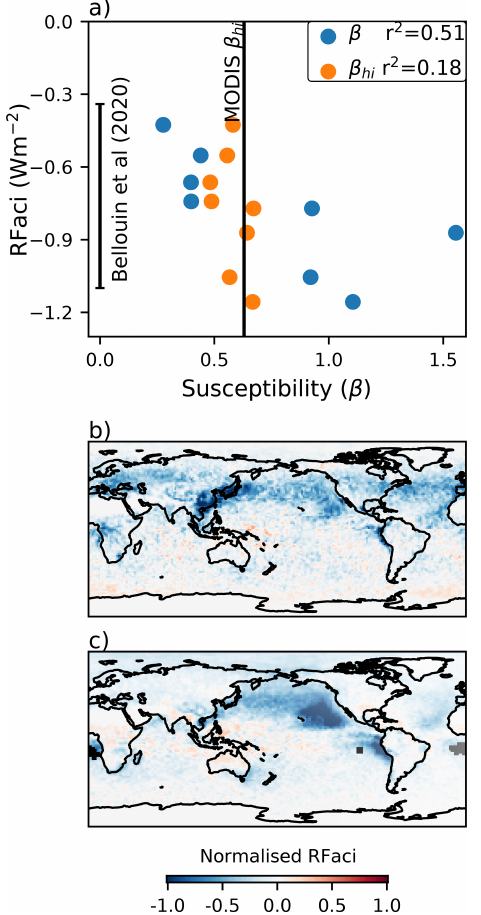
Figure 2. (a) The relationship between the radiative forcing from aerosol–cloud interactions (RFaci; calculated following Gryspeerdt et al., 2020): susceptibility ( β ) in all conditions (blue) and polluted conditions only ( β hi ; orange). The MODIS value for β hi and the RFaci range are given, following Bellouin et al. (2020). (b, c) The RFaci patterns from ECHAM6-HAM2.2 and CAM5.3-CLUBB- MG2 respectively (see Ghan et al., 2016), normalised to the same total radiative forcing.